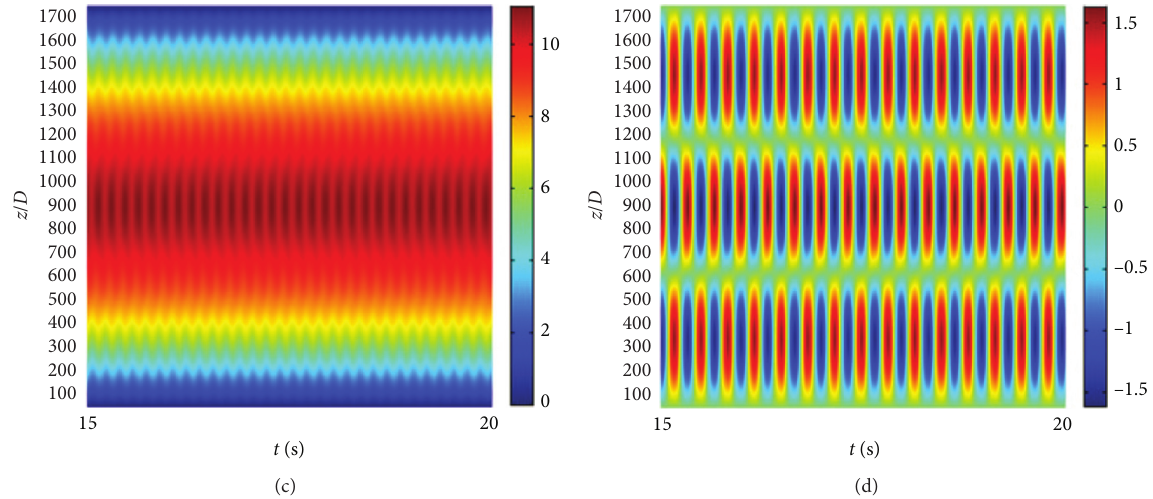
Figure 8: Space-time response of displacement under different viscoelastic coefficients. (a) The in-line and (b) cross-flow with a � 0.001. (c) The in-line and (d) cross-flow with a � 0.11.